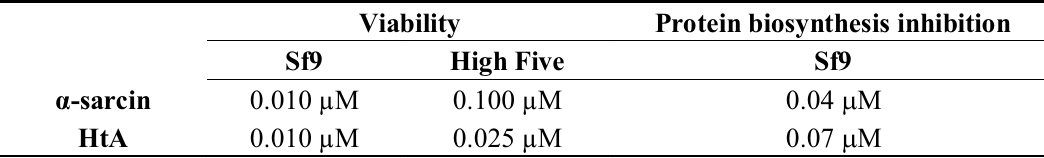
Table 1. IC values obtained for (cid:68) -sarcin and HtA when assayed against insect cell lines in 50